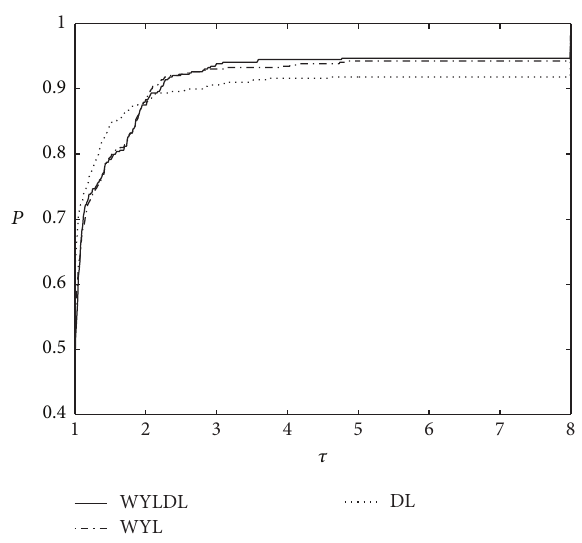
Figure 2: Performance profiles based on function and gradient